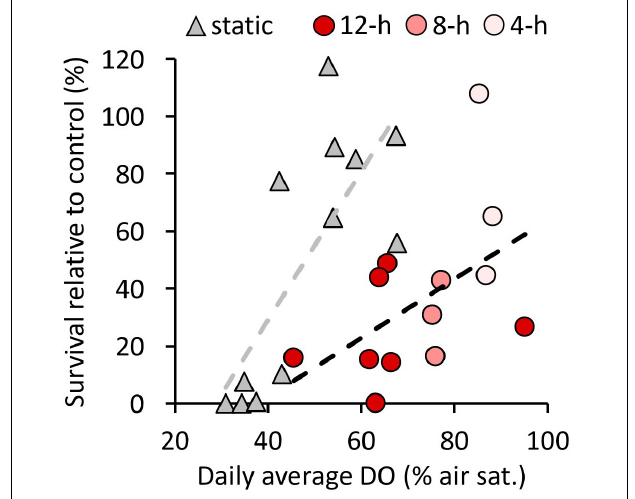
FIGURE 4 | Survival of Callinectes sapidus zoea I larvae (relative to control treatments) as a function of daily average DO over periods ≤ 96 h of static (triangle) or fluctuating (circle) low DO conditions. Each point represents one experimental low DO treatment from the five experiments conducted in this study and four experiments by Tomasetti et al. (2018). The shade of red indicates the duration of hypoxia over a diel cycle within the fluctuating treatments. See Supplementary Table 8 for collated